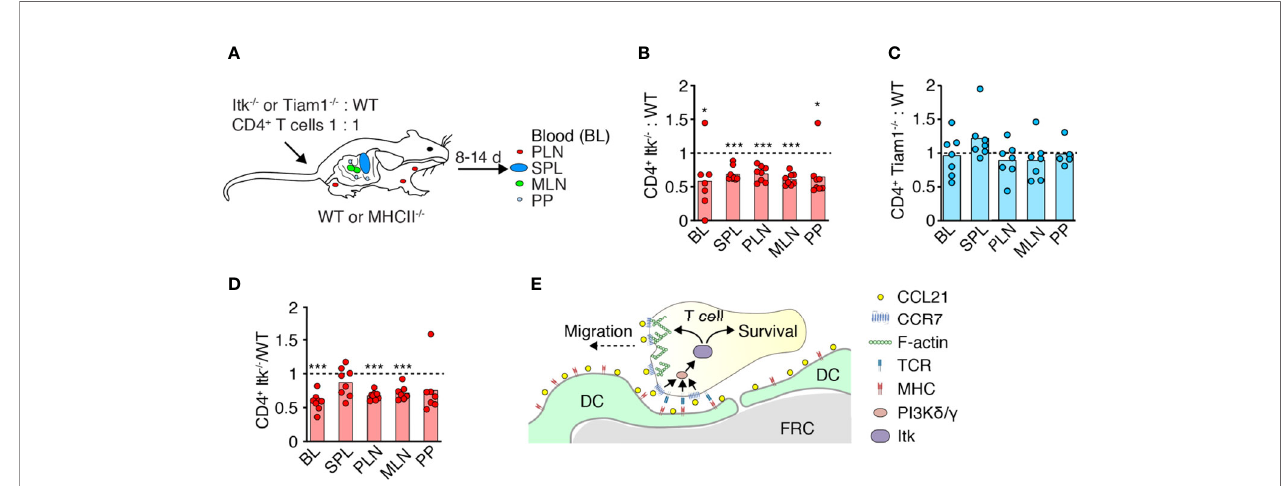
FIGURE 3 | Itk supports physiological T N homeostasis. (A) Experimental layout. Fluorescently labeled WT and Itk -/- or Tiam1 -/- CD4 + T N were transferred in a 1:1 ratio into WT or MHCII -/- recipients, and blood (BL), spleen (SPL), PLN, mesenteric LN (MLN), and Peyer ’ s patches (PP) were analyzed 8 – 14 days post transfer (p.t.) by fl ow cytometry. (B – D) Itk -/- or Tiam1 -/- to WT CD4 + T N ratio recovered 10 – 14 days p.t. into WT (B, C) or 8 days p.t. into MHCII -/- recipients (D) , normalized to input. (E) Scheme of Itk function in T N migration and survival. Data in (B – D) are from two independent experiments and analyzed by a one-sample t-test against the theoretical value of “ 1 ” (= equal recovery). *p < 0.05; ***p <